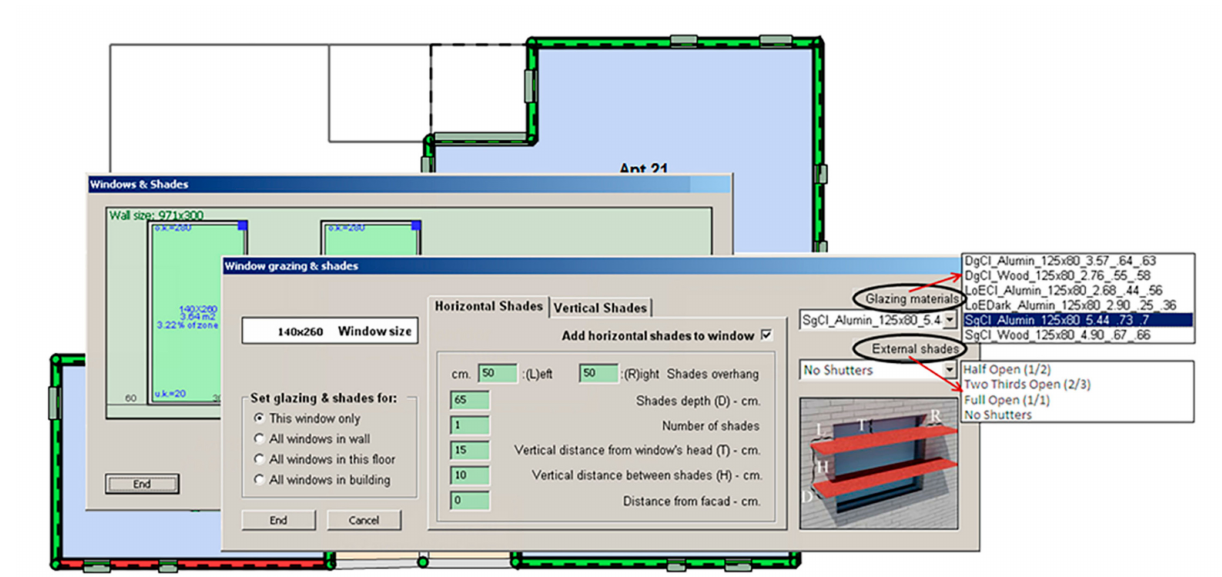
Figure 6. Openings: Assignment of window and shading